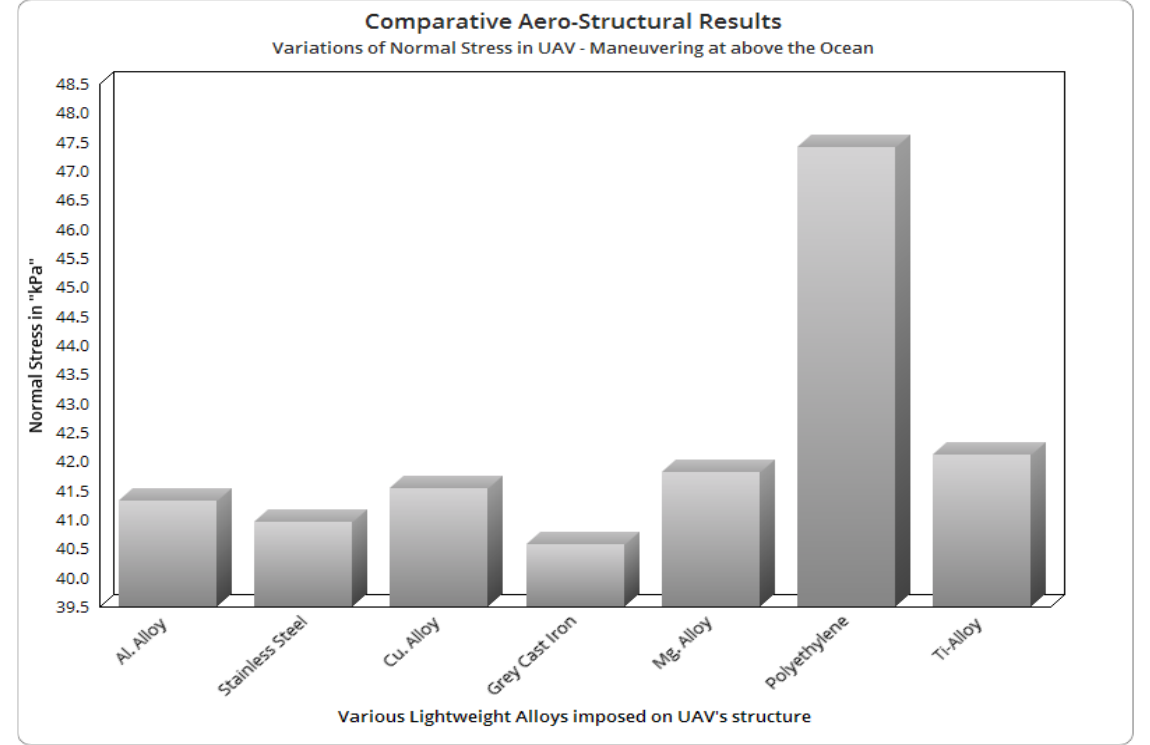
Figure 19. Comparative Equivalent Stress Variations for various composites.